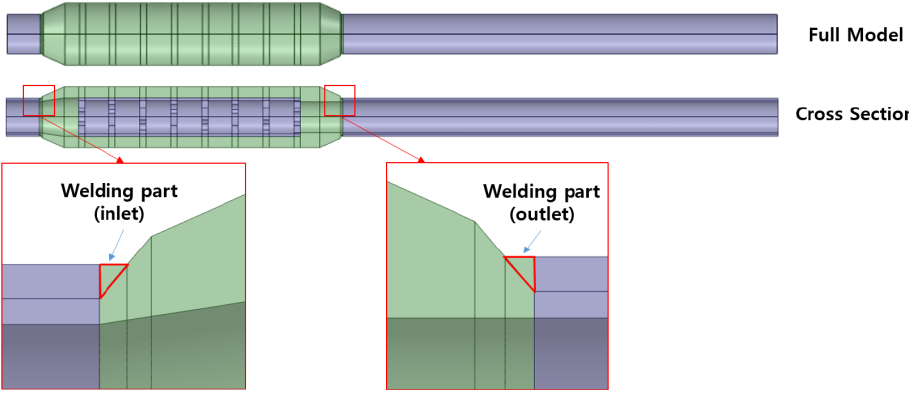
Figure 8. Geometry modeling for the structural analysis of the eight-stage orifice.